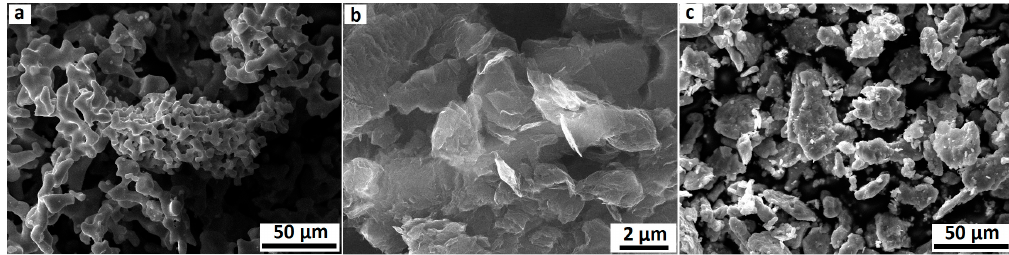
Figure 1. SEM image of ( a ) pure titanium powder before ball milling, ( b ) graphene nanosheets (GNSs) before ball milling, and ( c ) mixed powders after ball milling.